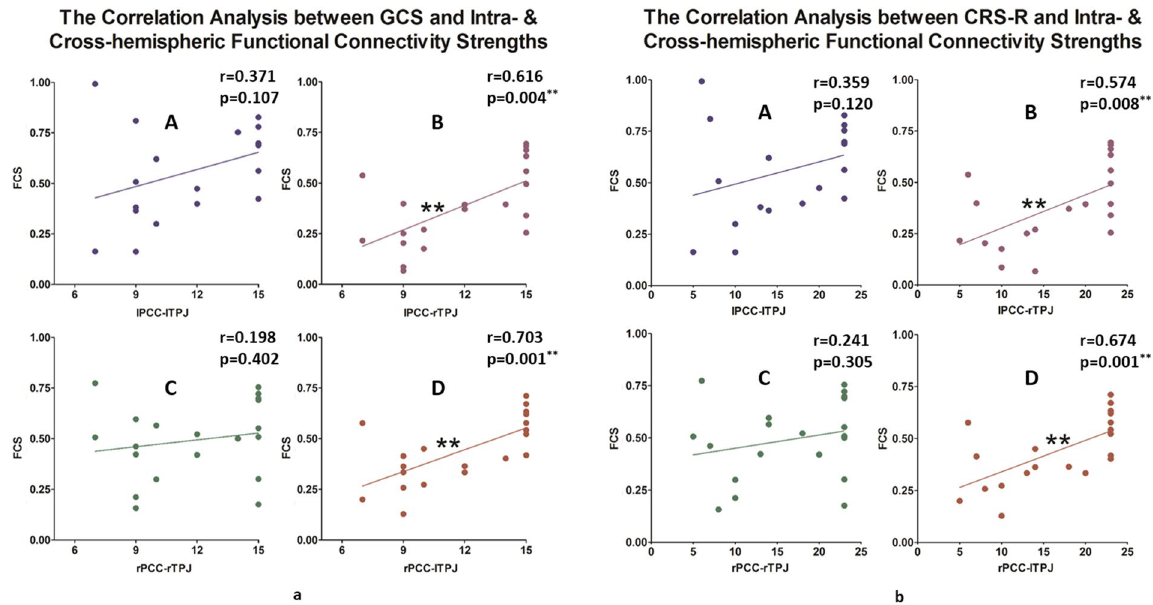
Figure 4. ( A , B ) The Spearman’s correlation of the PCC-PTJ FCSs with both the GCS scores and the CRS-R scores in the TBI patient group. The cross-hemispherical FCSs were significantly correlated with the consciousness level for both scales. ( A,C ): Intra-hemispheric functional connectivity (lPCC-lTPJ and rPCC- rTPJ). ( B,D ): Cross-hemispheric functional connectivity (lPCC-rTPJ and rPCC-lTPJ). ** α = 0.01; * α = 0.05.